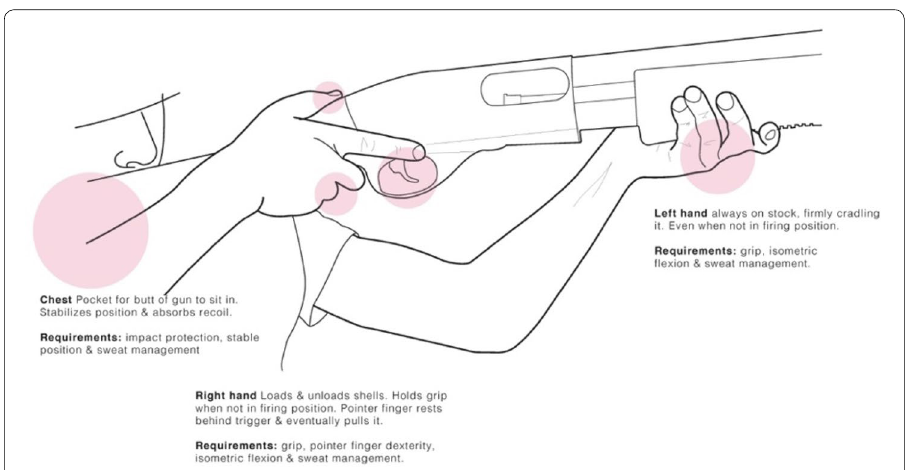
Fig. 13 Clay pigeon shooter physiological and biomechanical needs (Echols